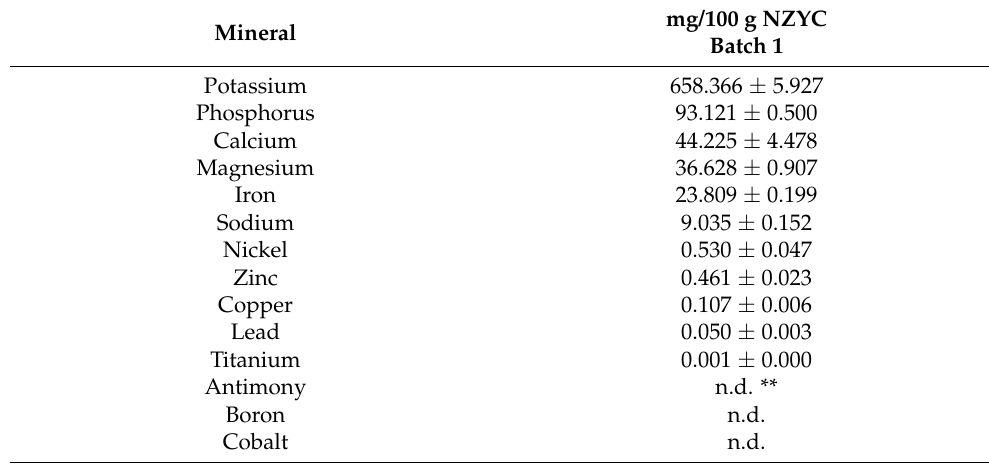
Table 2. Mineral profile of NZYC as determined by microwaveplasma atomic emission spectrometry ( n = 3).